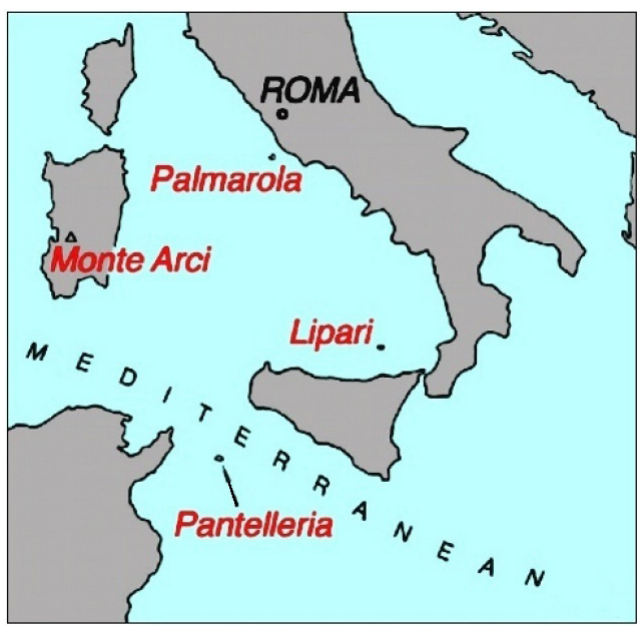
Figure 1: Location of the four obsidian sources exploited in prehistoric times in the Central Mediterranean